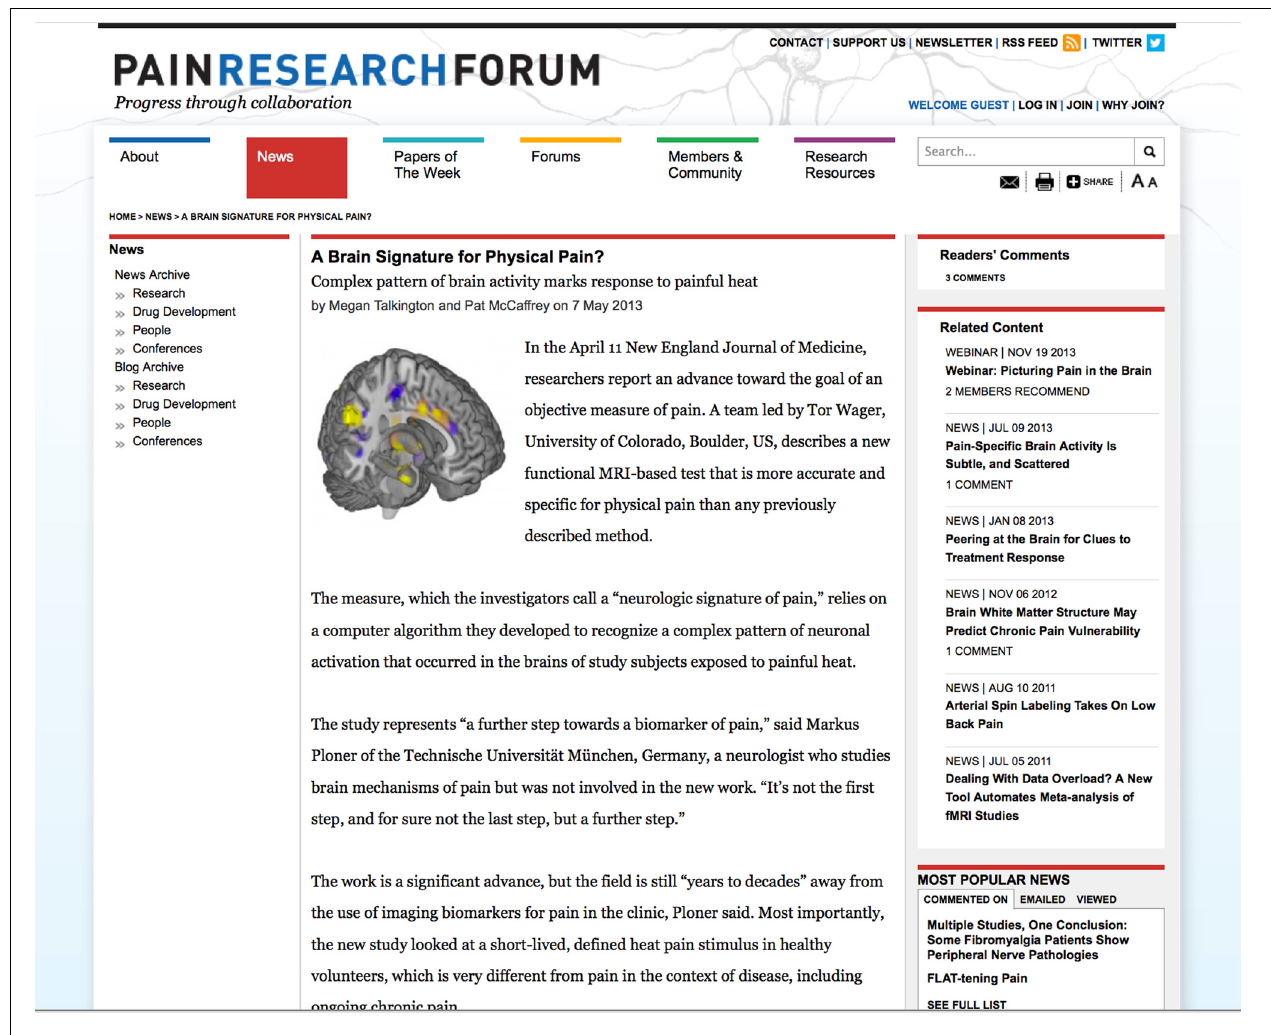
FIGURE 4 | News story on brain imaging. Screenshot of news story on brain imaging study (http://www.painresearchforum.org/news/27192-brain- signature-physical-pain). Study was led by Tor Wager, University of Colorado,